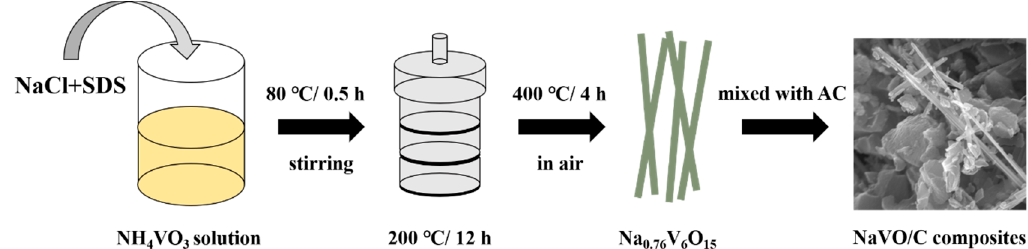
Figure 1. Synthesis process of the NaVO/C hybrids.